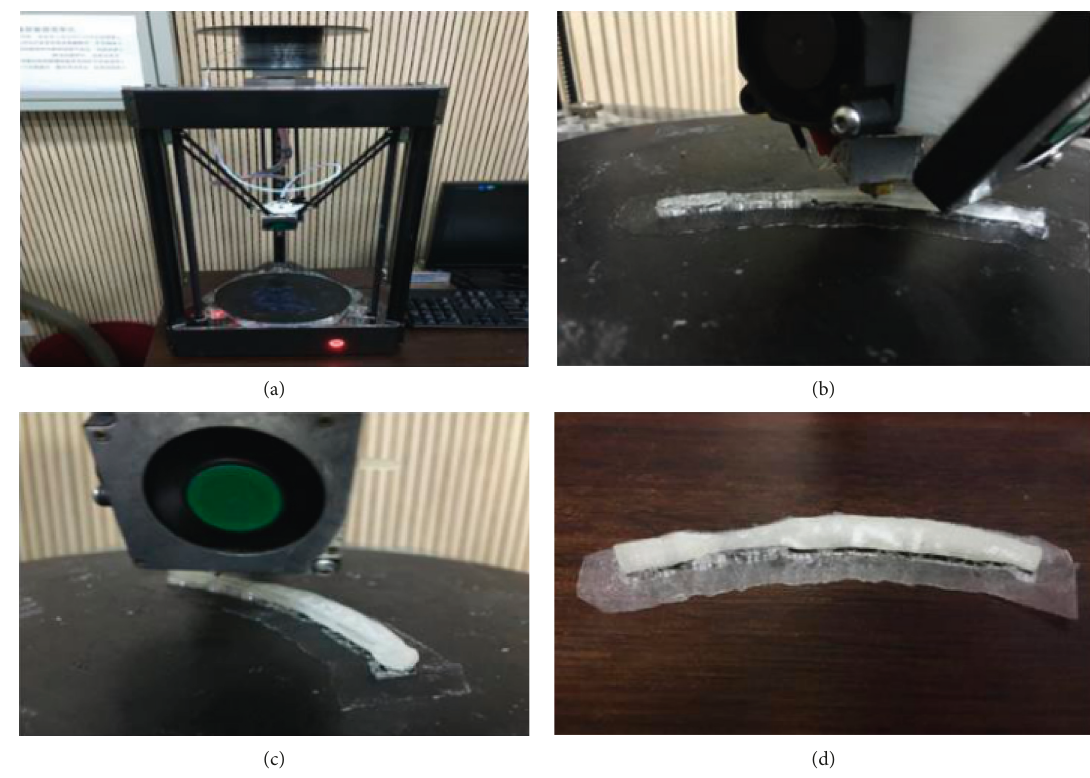
Figure 6: The process of 3D printing a specific vascular